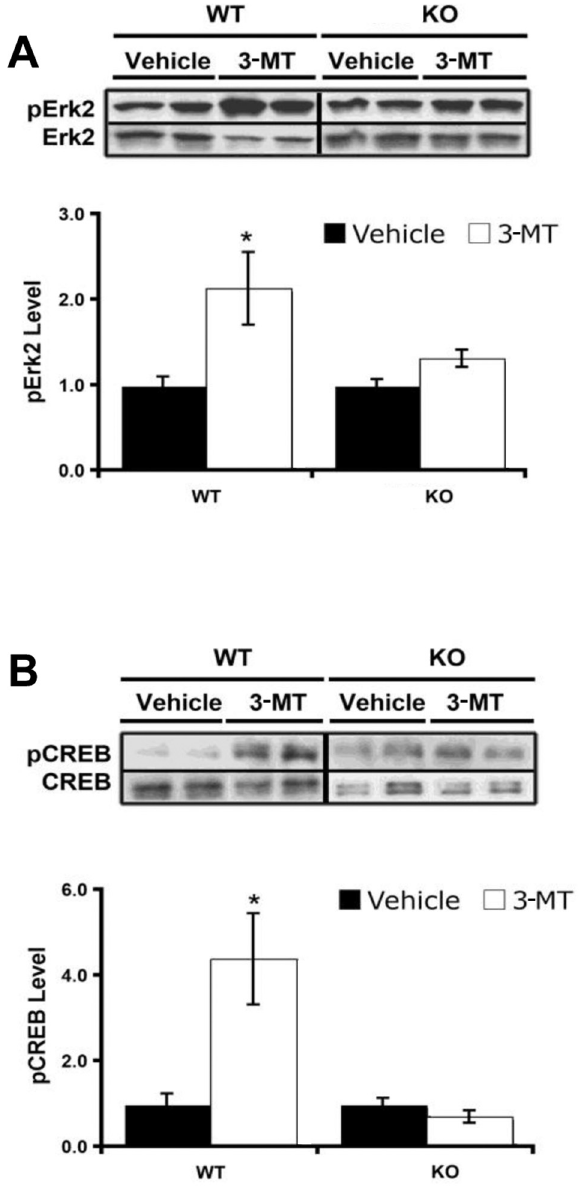
Figure 4. Striatal signaling effects of 3-MT are reduced in TAAR1-KO mice. Effect of 3-MT infusion (18 m g, 30 min after treatment) on Erk2 (A) and CREB (B) phosphorylation in WT and TAAR1-KO mice. 3-MT induced significant phosphorylation of both Erk2 and CREB in WT mice, but not in TAAR1-KO mice (* p , 0.05; Student’s t- test n=10 per group).